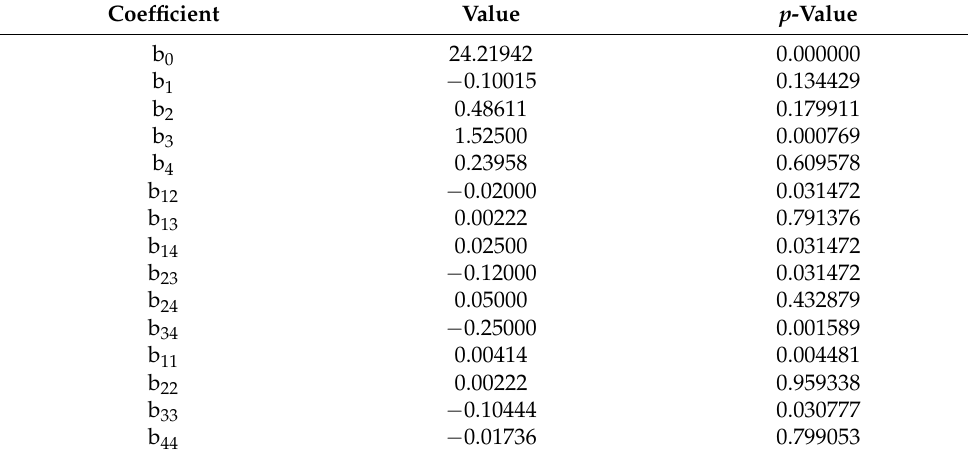
Table 7. Coefficients of regression equation and their p -values for the diameter of the inhibition zone for Aspergillus flavus PA2DSS as test microorganism.